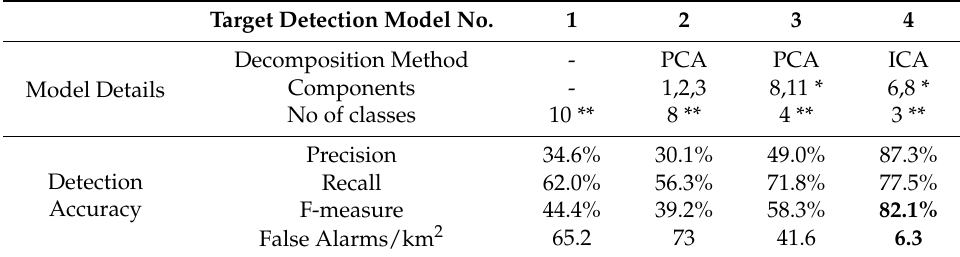
Table 1. Details and detection accuracy statistics regarding the 4 automatic target detection models considered here, as applied to the case study of Alexandroupolis Harbor. The 4th model corresponds to the proposed approach in this study.